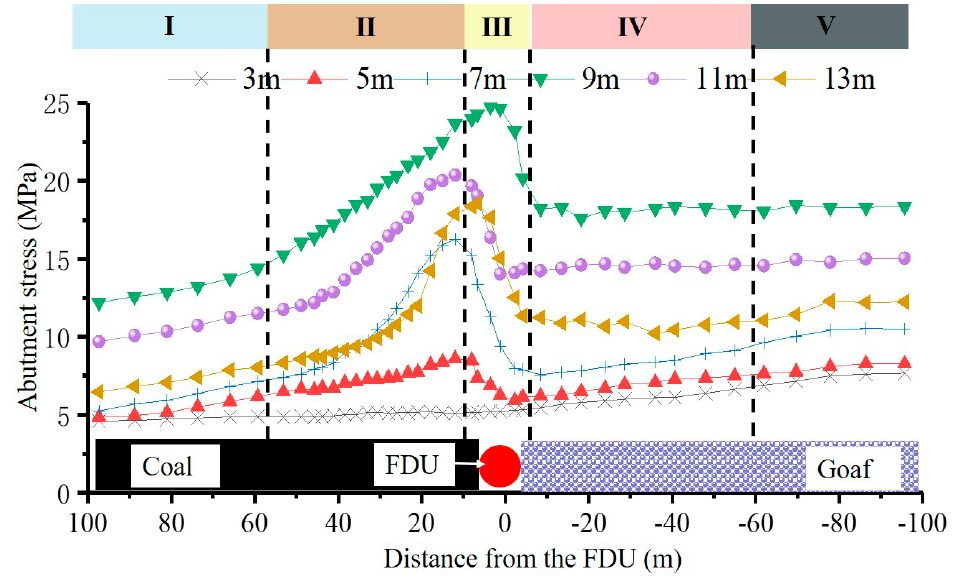
Figure 12. Strike abutment pressure curve of the roof-cutting entry (tail entry) of station 2#.